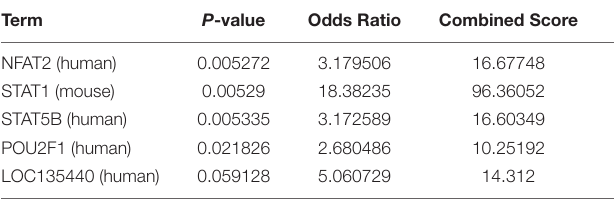
TABLE 4 | The potential transcript factors of CLEC4s based on Enrichr. Term